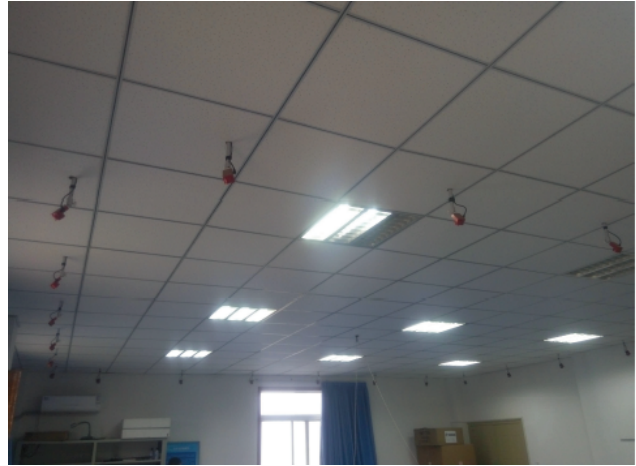
Figure 4. OptiTrack motion capture